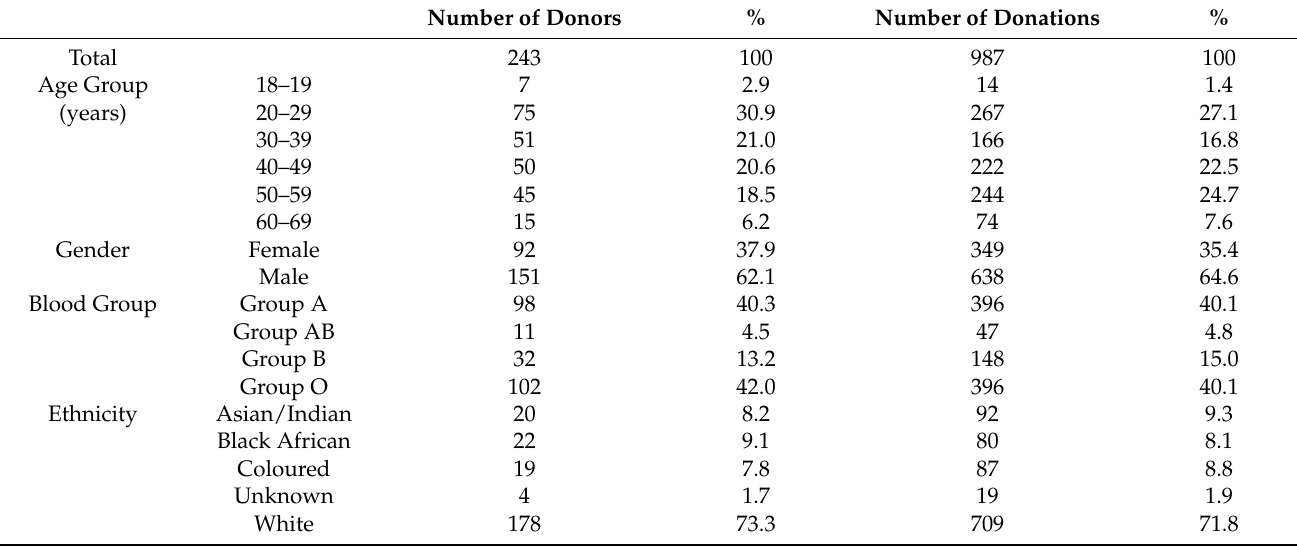
Table 2. Age group, gender, blood group and ethnicity classification of enrolled